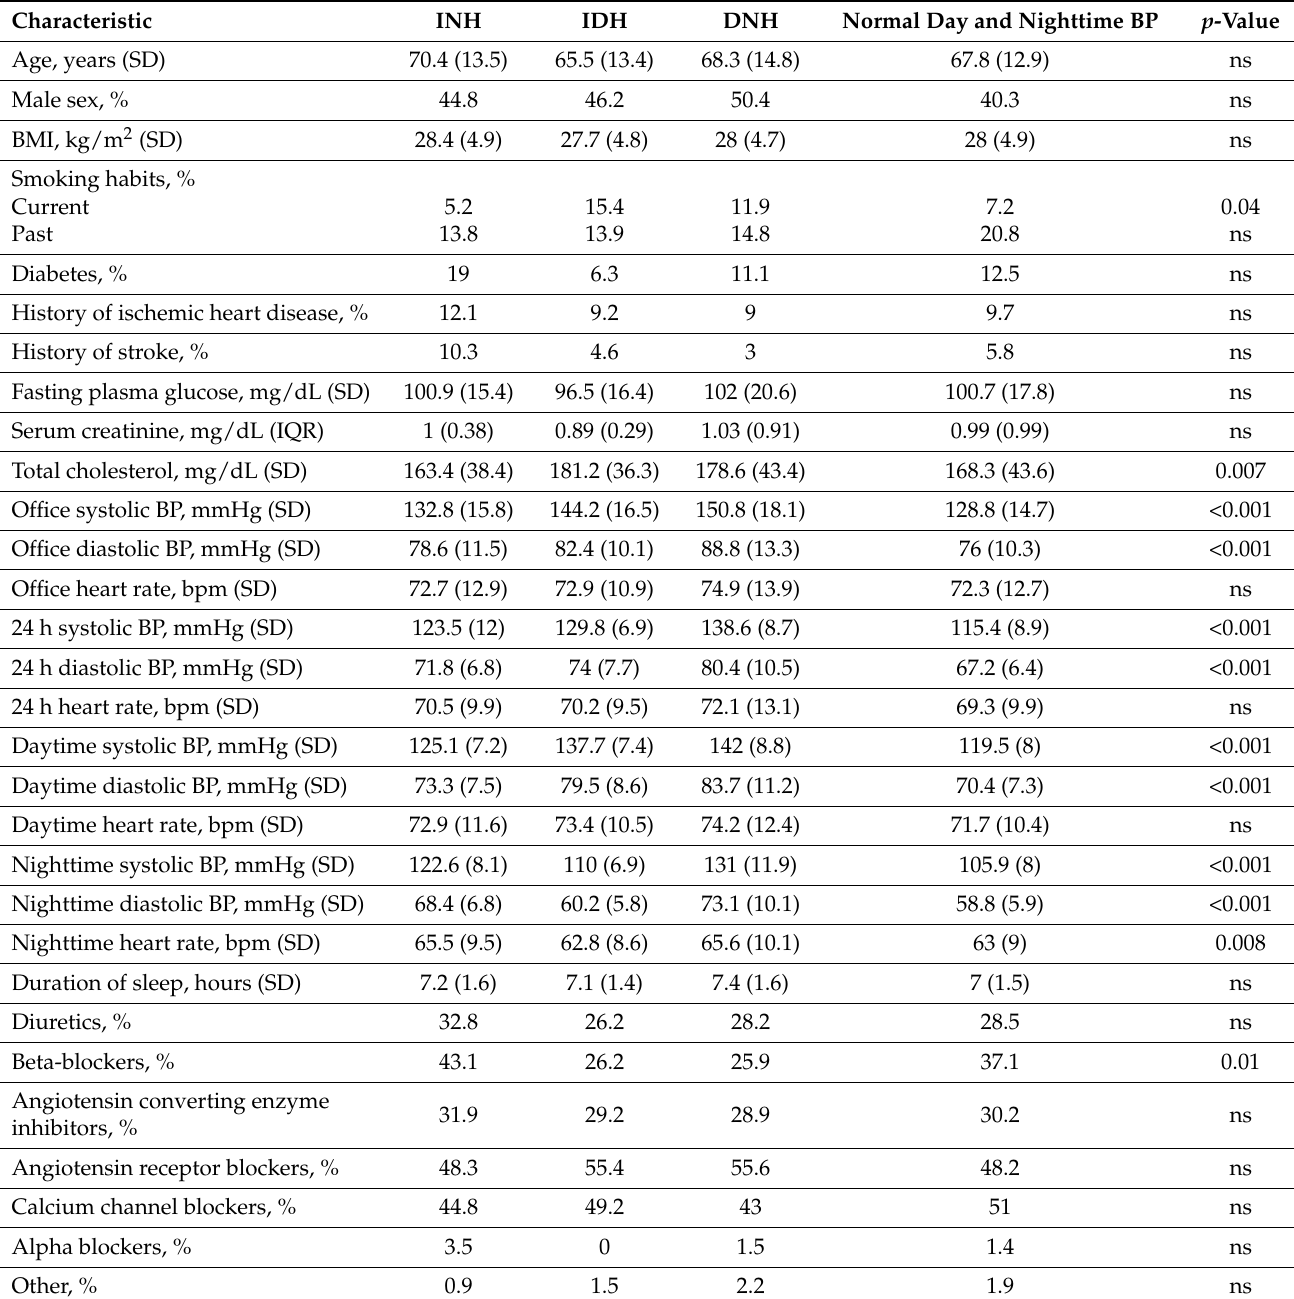
Table 6. Comparison between subjects with isolated nocturnal hypertension, isolated diurnal hyperten- sion, day and nighttime hypertension, and day and nighttime normal BP among treated participants.